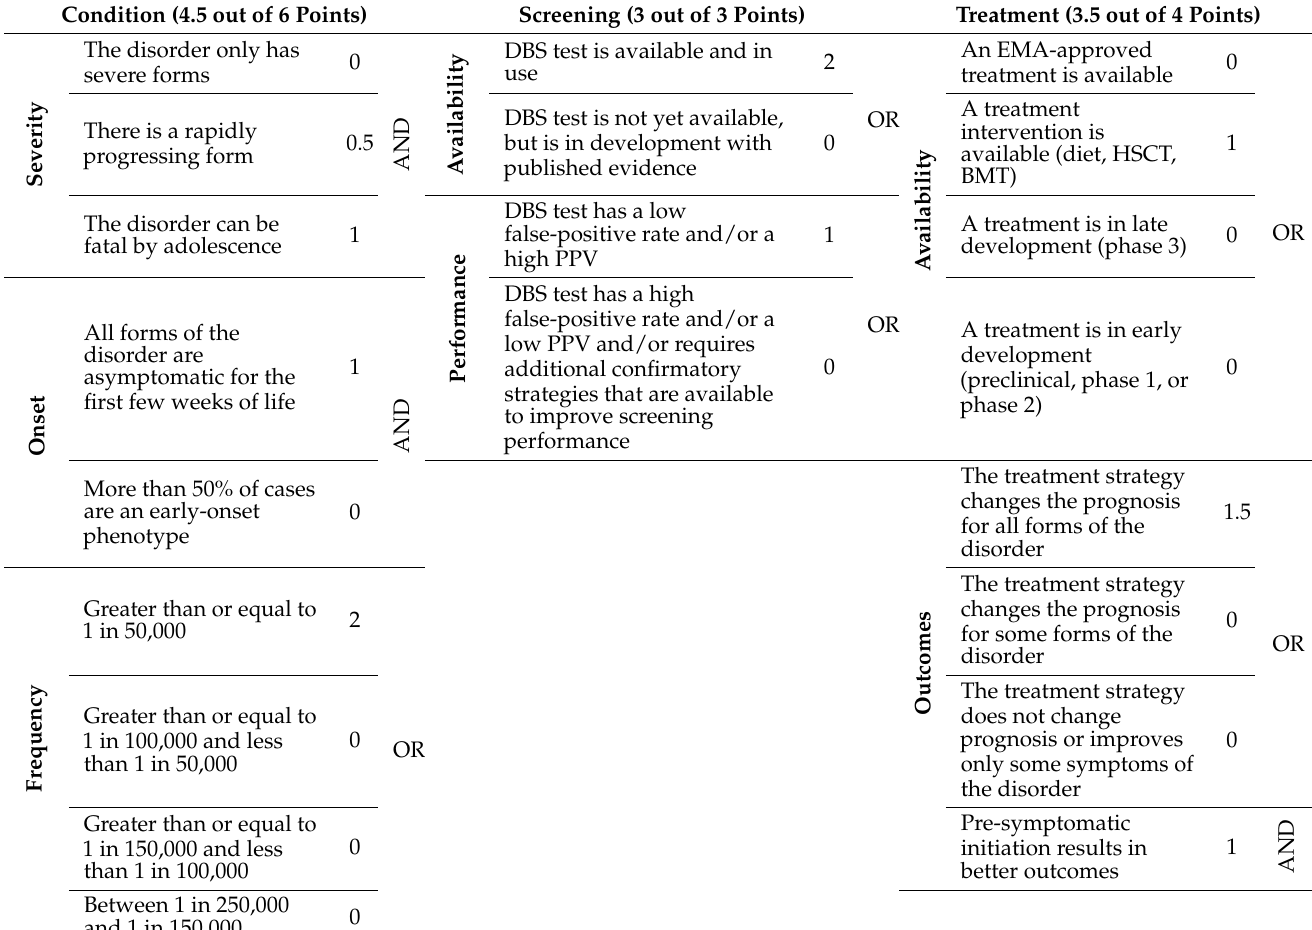
Table A7. Medium-chain acyl-CoA dehydrogenase deficiency (MCADD), 11